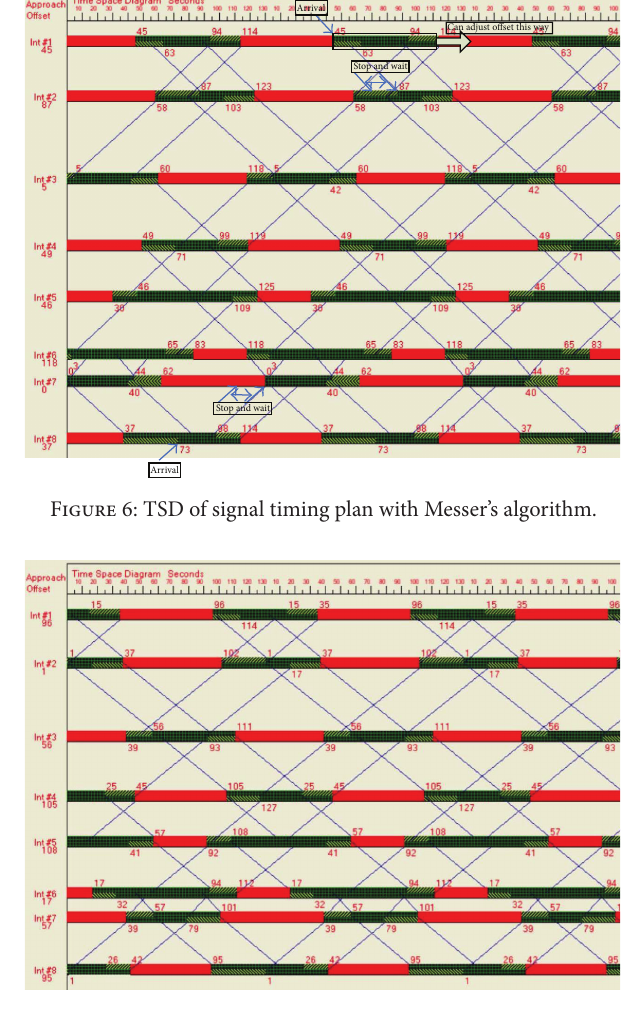
the proposed bandwidth optimization algorithm and get the TSD with maximum progression of arterial bandwidth and link bandwidth for